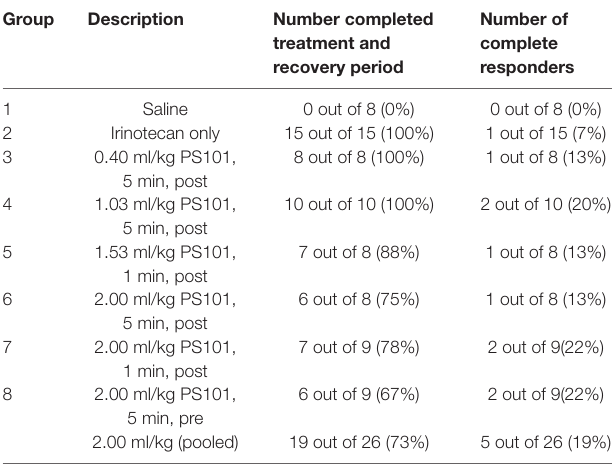
TABle 3 | Summary of the number of mice that were able to complete the treatment plus recovery period, and the number of complete responders for each group. group